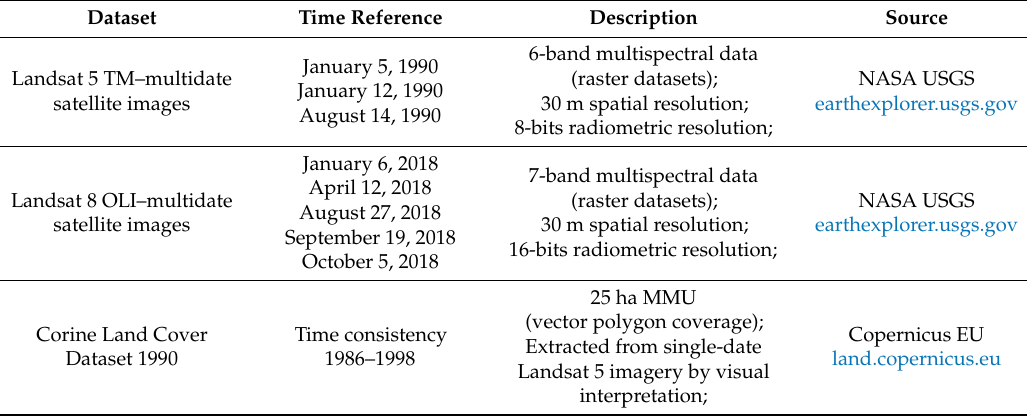
Table 1. Data types and data sources used in the